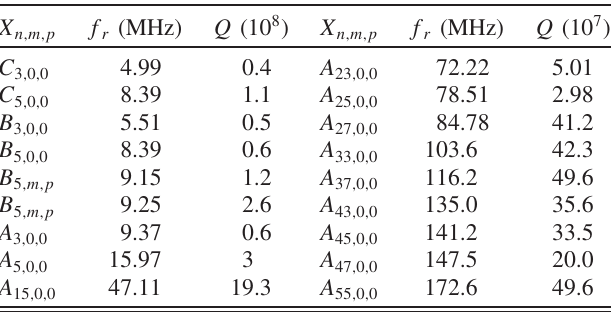
TABLE IV. Values of Q factors for some overtones of cryogenic (4K) BAW